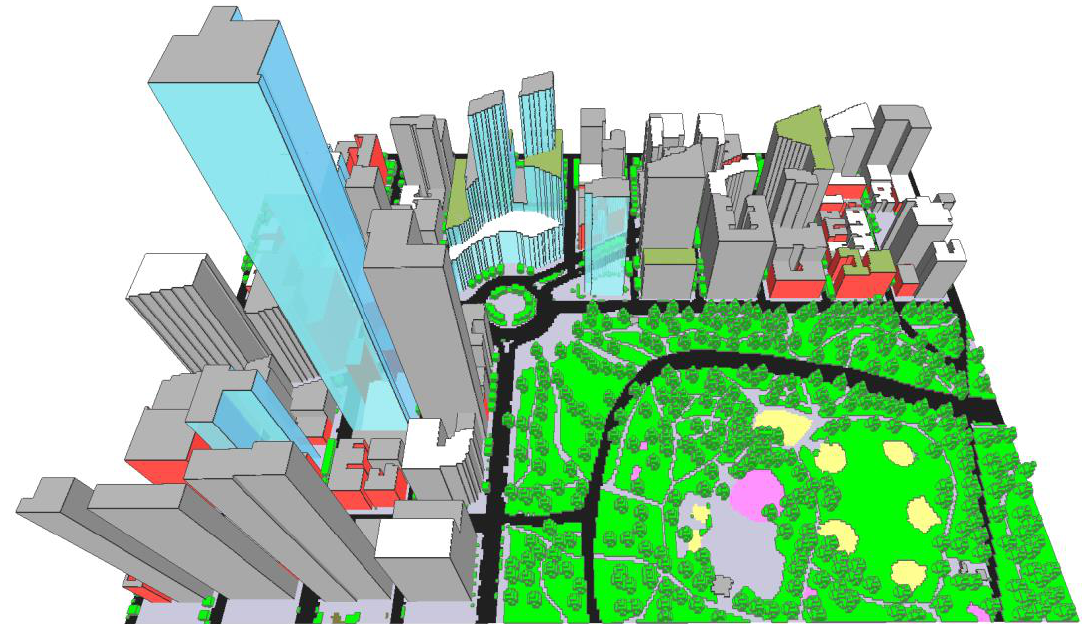
Figure 2. Example model area at the edge of Central Park in NYC modeled for the proof-of-concept simulations. Different colors indicate different material properties. Non-default ENVI-met database item properties are defined in Table 1. Grey façades/roofs indicate concrete walls and default roofs, respectively; blue transmissive façades indicate glass walls; red façades indicate brick walls; white roofs indicate cool roofs; green façades indicate default roofs with default greenery 01NASS being applied; green surfaces indicate default open soil 0100SL and default grass 0100XX; black surfaces indicate default asphalt road 0100ST; grey surfaces indicate default pavement 0100PP; pink surfaces indicate basalt rock profile entirely filled with default 0000BA soil; yellow surfaces indicate default sand profile 0100SD. Table 1. Summary of material properties in the proof-of-concept simulation [51].